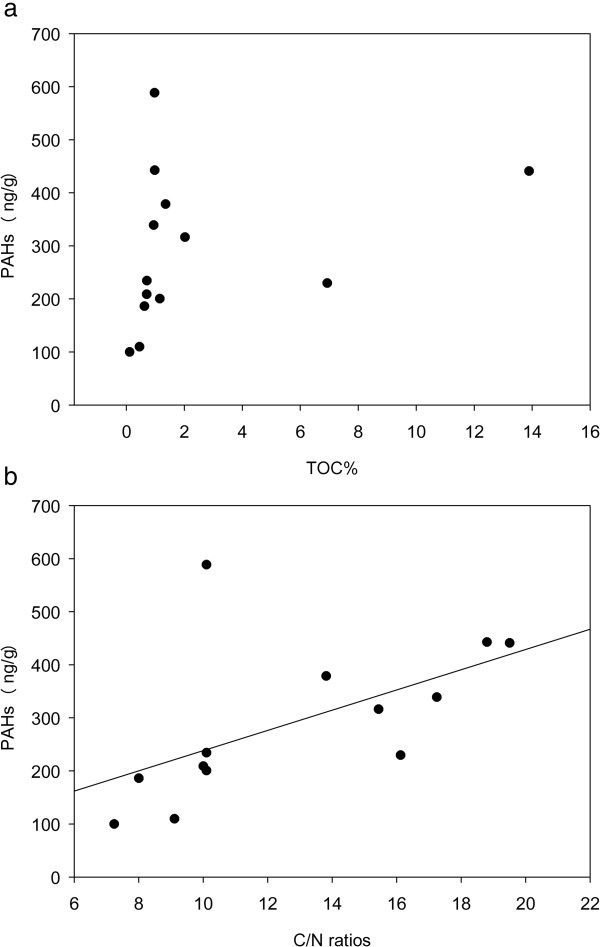
Relationship between PAH concentrations and (a) TOC (r = 0.3), and (b) C/N ratios (r = 0.75, p < 0.01) in sediments. The MRM sediment in May 2010 was excluded due to its exceptionally high PAH concentration.